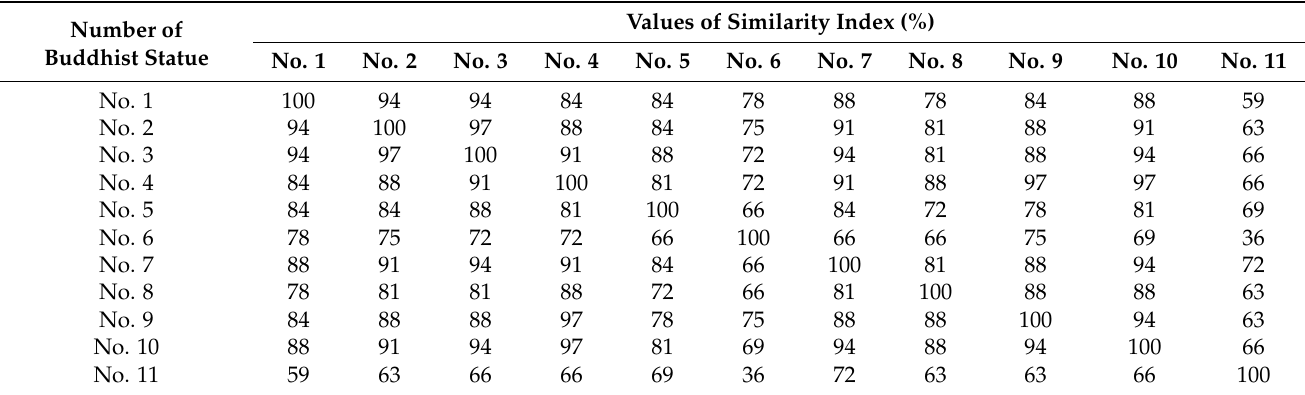
Figure 10. The experimental object in this paper. ( a ) Orthophoto of Buddhist statue No. 1; ( b ) Orthophoto of Buddhist statue No. 2; ( c ) Orthophoto of Buddhist statue No. 3; ( d ) Orthophoto of Buddhist statue No. 4; ( e ) Orthophoto of Buddhist statue No. 5; ( f ) Orthophoto of Buddhist statue No. 6; ( g ) Orthophoto of Buddhist statue No. 7; ( h ) Orthophoto of Buddhist statue No. 8; ( i ) Orthophoto of Buddhist statue No. 9; ( j ) Orthophoto of Buddhist statue No. 10; ( k ) Orthophoto of Buddhist statue No. 11. Table 3. Statistics of experimental results.